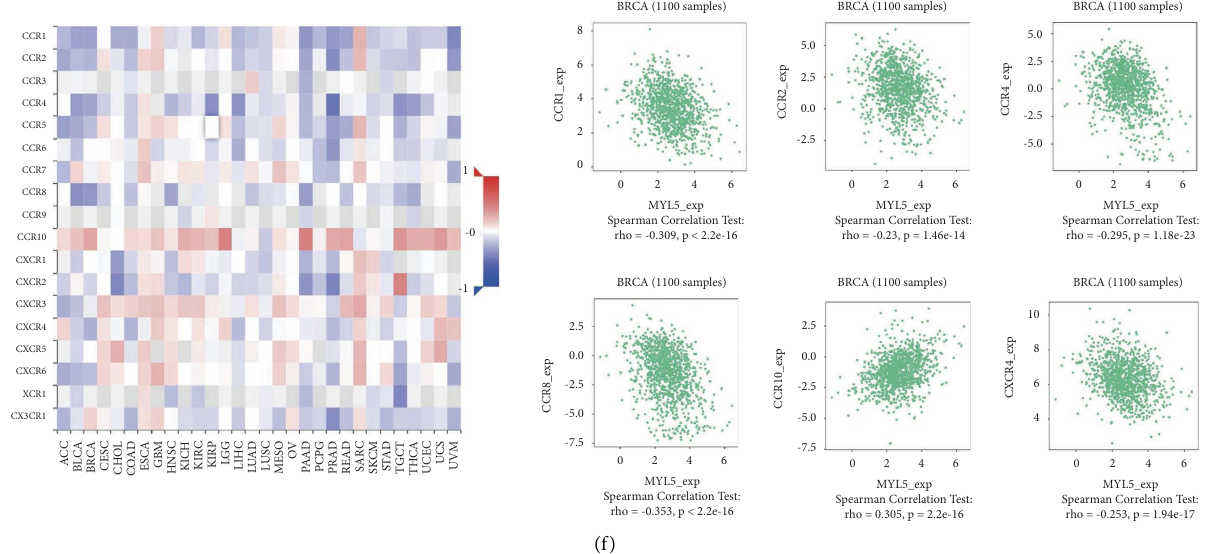
Figure 8: Connections of the expression level of MYL5 of BRCA patients with lymphocytes, immunomodulators, and chemokines in the TISIDB database. (a) Te relationship between TILs and MYL5. (b–d) Te relations between immunomodulators and MYL5. (e) and (f) Correlations of chemokines (or receptors) and